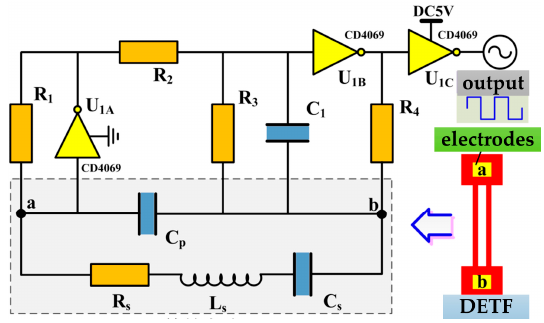
Figure 13. Self-excitation circuit and output square wave.